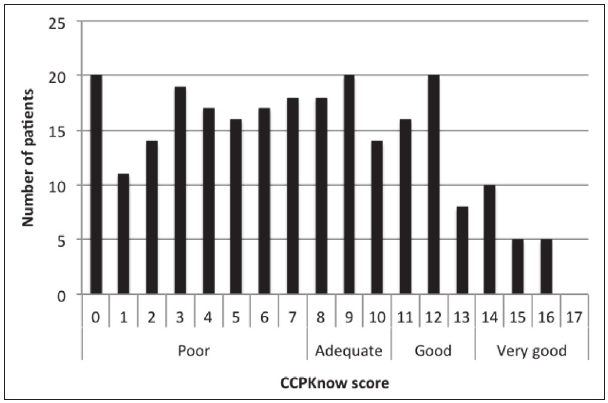
Figure 1) Distribution of Crohn’s and Colitis Pregnancy Knowledge sur- vey (CCPKnow) scores measuring inflammatory bowel disease (IBD)- specific reproductive knowledge among 248 female IBD patients from the IBD Consultation and Research Clinic, University of Alberta Hospital (Edmonton, Aberta), 2010 to 2013 (n=248). Poor n=131/248 (52.8%); Adequate n=49/248 (19.8%); Good n=48/248 (19.4%); Very good n=20/248